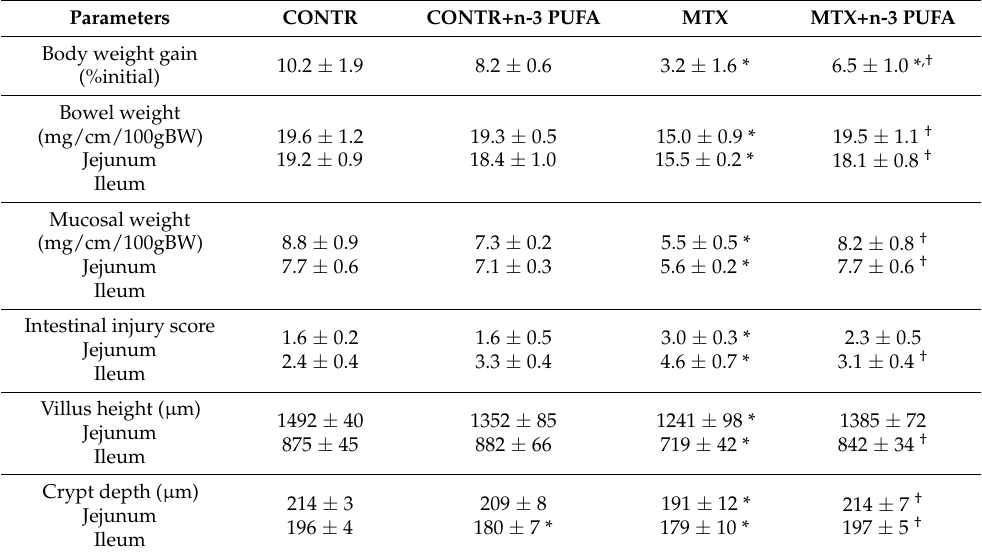
Table 1. Effect of methotrexate and n-3 PUFAs on body weight gain, intestinal mucosal parameters and intestinal injury